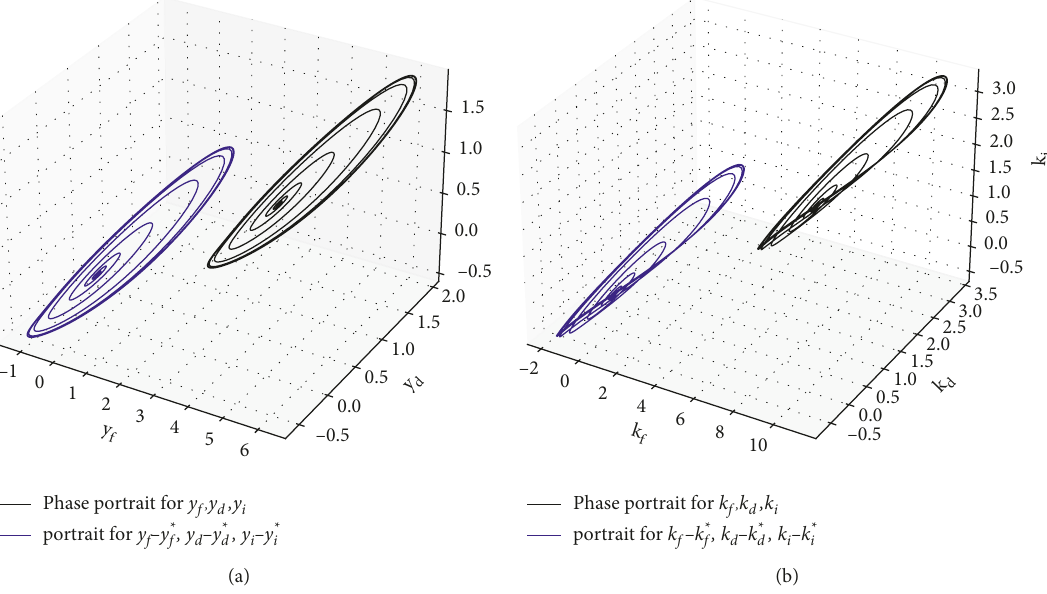
− y − y f d i space in black and the transformed one in blue. (b) Phase